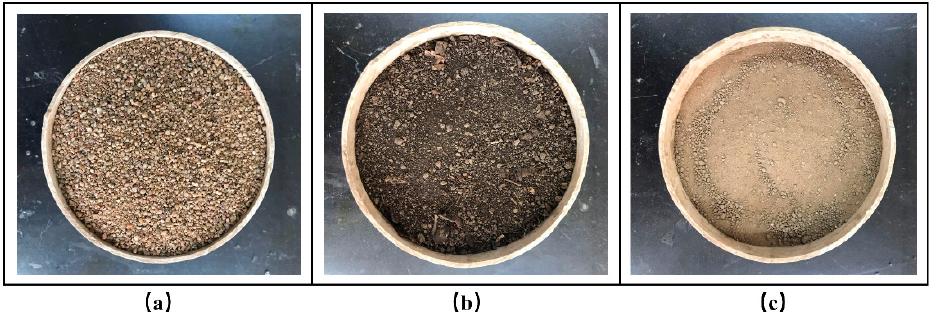
Figure 3. Soil samples of different textures: (a) Sandy soil, (b) forest humus, (c) sandy loam.